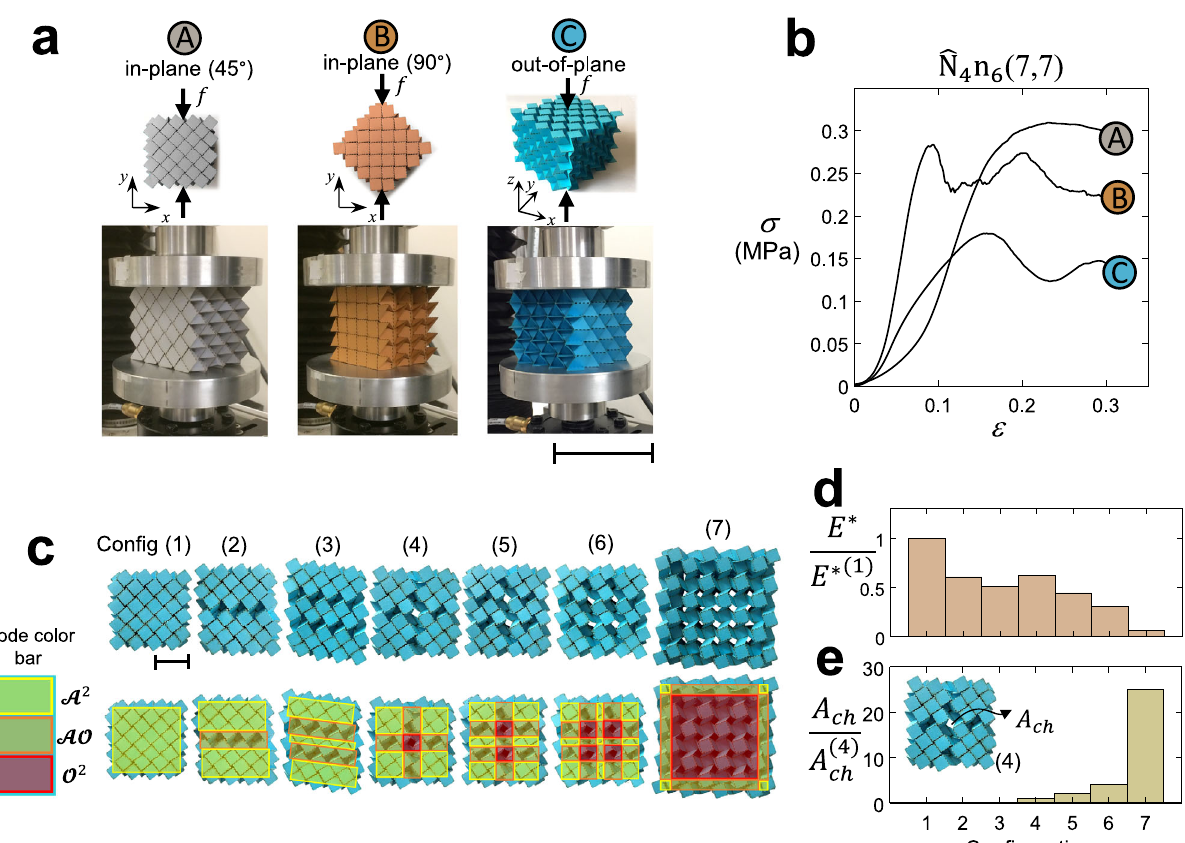
Fig. 6 Multidirectional load-bearing capacity and in situ programmability. a Directions (two in-plane and one out-of-plane) of the applied compressive loads relative to the orientation of the ^ N 4 n 6 ð 7 ; 7 Þ specimen, and b their corresponding representative engineering stress-strain responses : Scale bar in a = 100 mm. c Top view of seven mixed-mode con fi gur a tions of ^ N 4 n 6 ð 7 ; 7 Þ with a = b = 10 mm: Scale bar in c = 30 mm. Regions of a given mixed-mode highlighted in semitransparent color for A 2 , O 2 and AO . Out-of-plane normalized compressive Young ’ s modulus d and normalized open-channel (void) area in the out-of-plane direction e for the seven con fi gurations shown in c